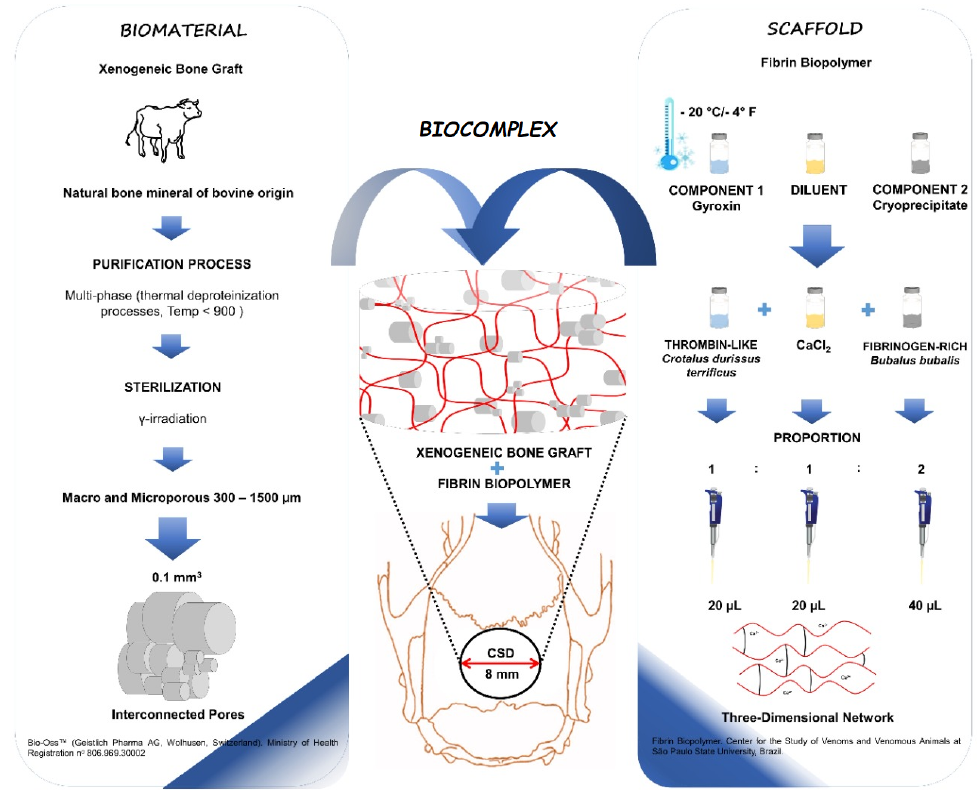
Figure 1. Schematic drawing of the production of the scaffolds used in this experimental protocol, the xenogeneic bone graft (Bio-Oss TM ) and the fibrin biopolymer (CEVAP/UNESP). In the center of the image, the incorporation of the granular particles of the biomaterial into the fibrin biopolymer is represented, forming the biocomplex that was the filling material for bone defects of 8 mm in diameter in the center of the parietal bones of all